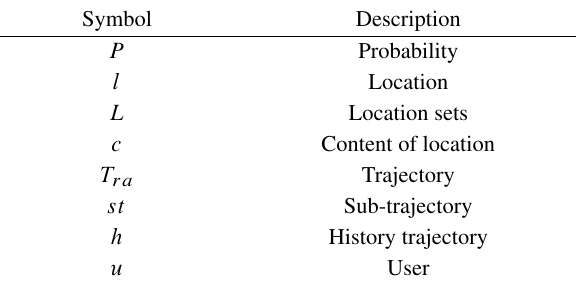
Table 2 Main symbols used in location prediction models.